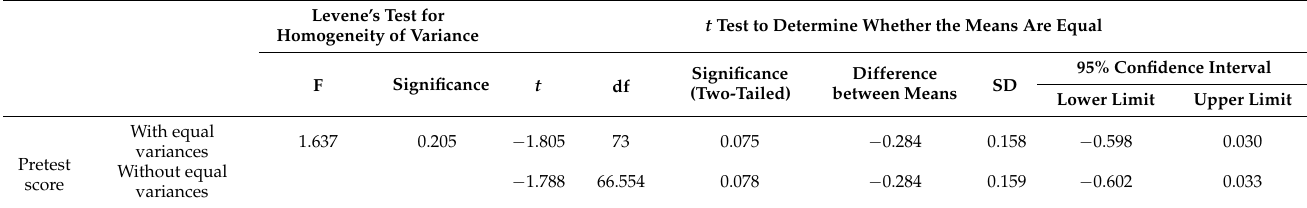
Table 4. Homogeneity of regression coefficients within the experimental teaching group. Levene’s Test for Homogeneity of